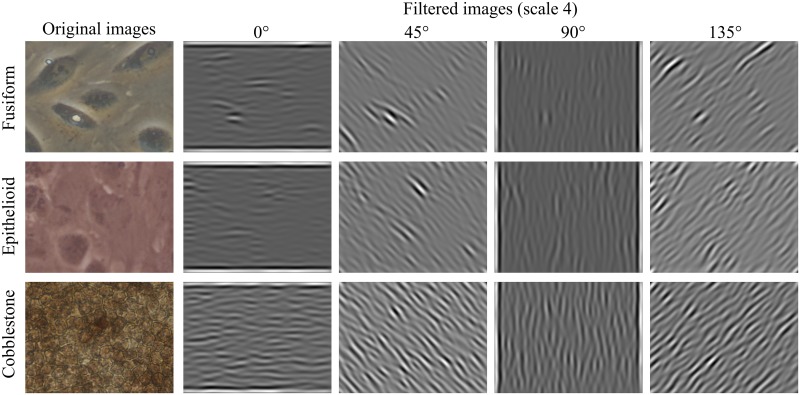
Preprocessing by Gabor filters.Rows represent the three classes fusiform, epithelioid and cobblestone. Left: original image; right: convolved images at scale 4.